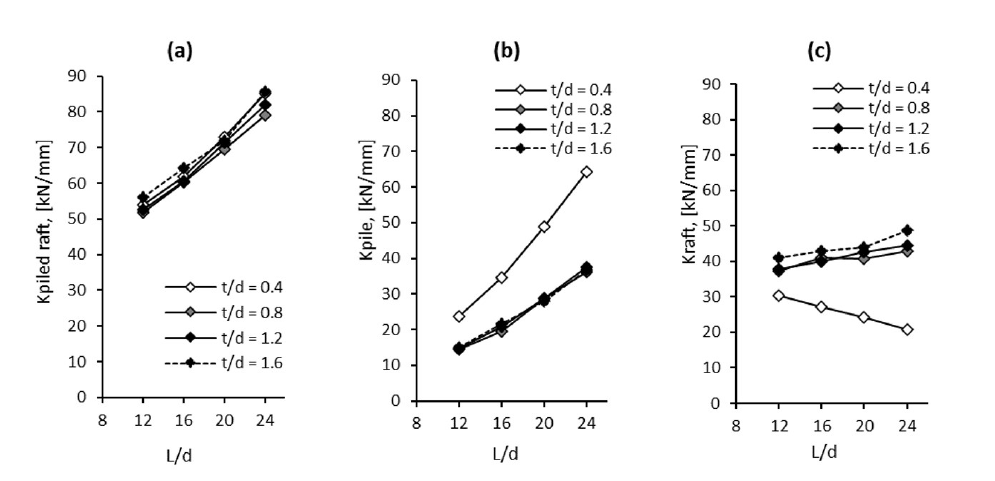
Figure 26. Effect of L/d ratio on piled raft, pile and raft